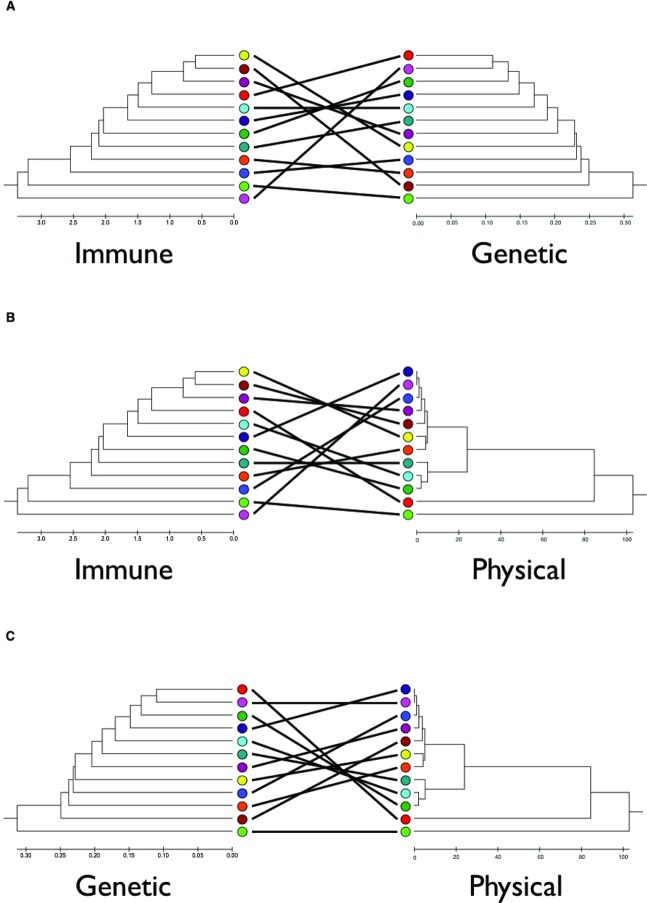
Immunological distance is not explained by genetic or physical distance.Tanglegrams based on unweighted pair group method with arithmetic mean (UPGMA) trees of immunological distance, genetic distance, as Fst, and geographical distance among sites, where the scales are the relevant measures (S1, S2 and S3 Tables) of (A) immunological and genetic, (B) immunological and geographical, and (C) genetic and geographical distance among mice from the different sites. The site colour coding is as in Fig 1.